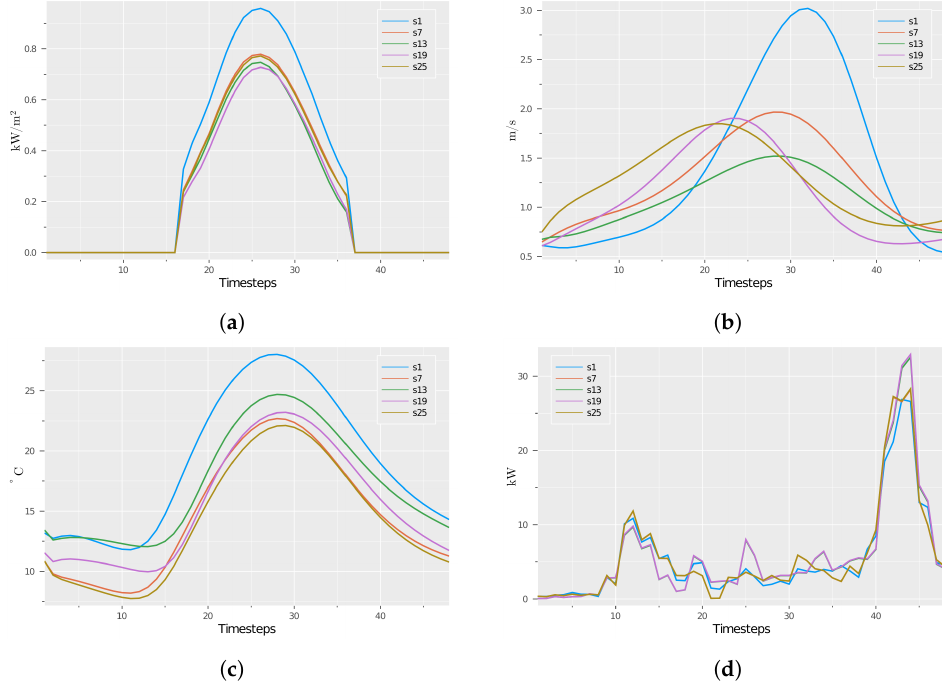
Figure 17. Scenarios created from RNN forecast. ( a ) GHI. ( b ) Wind speed. ( c ) Temperature. ( d ) Power